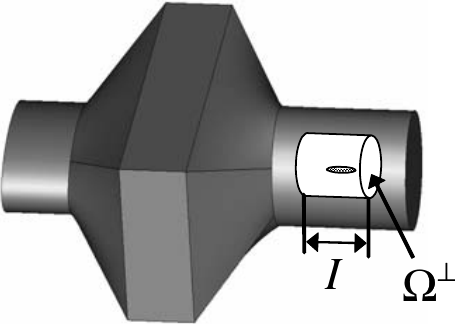
FIG. 4. The tapered cavity and area (cid:1) ? (cid:8) I around the